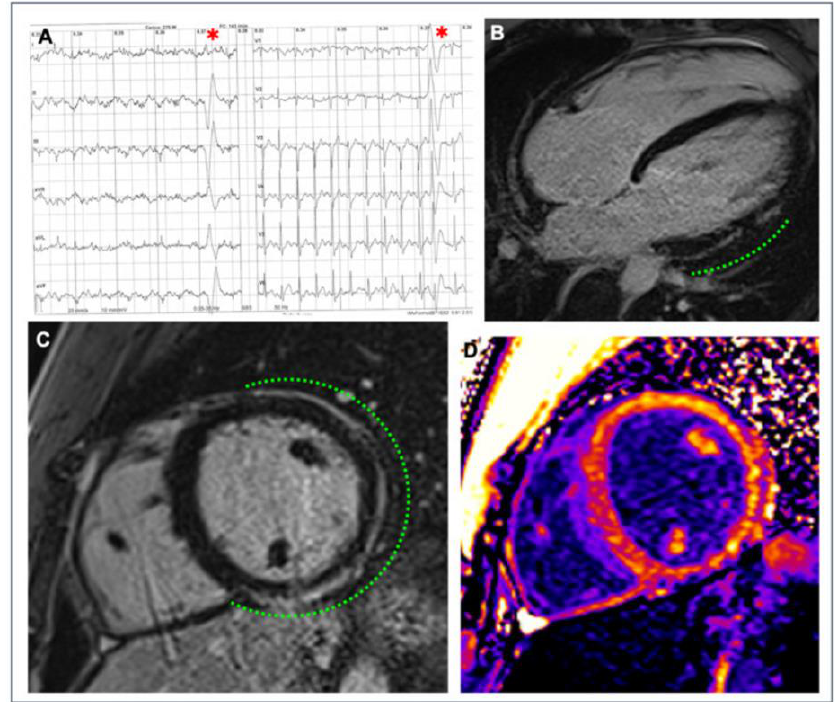
Figure 5. Example of a myocardial scar in an athlete. A competitive hockey player aged 26 at the pre-participation screening during exercise testing showed frequent PVBs with right bundle branch block/superior axis morphology at high workload (( A ), red asterisks). Post-contrast sequences on CMR revealed a subepicardial stria of LGE involving the anterior, lateral, and inferior LV walls in their basal and medium portions, with a “ring-like” pattern (green dotted line; ( B ) 4-chamber view; ( C ) short-axis view). Increased signal in the correspondent areas of fibrosis in the native T1 mapping short-axis sequence ( D ). Reproduced with permission from Brunetti et al. [129].